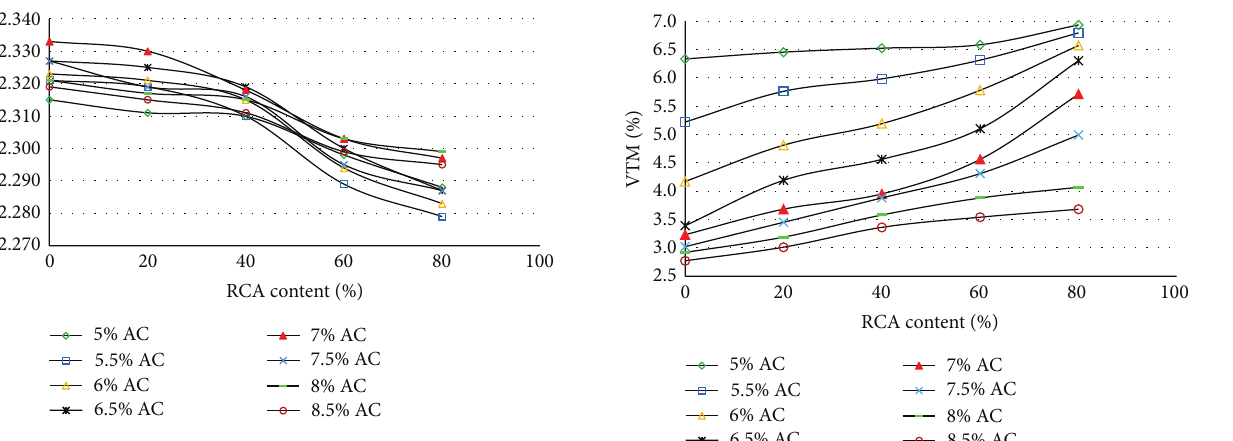
Figure 3: Specific gravity values versus RCA content for each percentage of asphalt content. Figure 4: VTM values versus RCA content for each percentage of asphalt content.